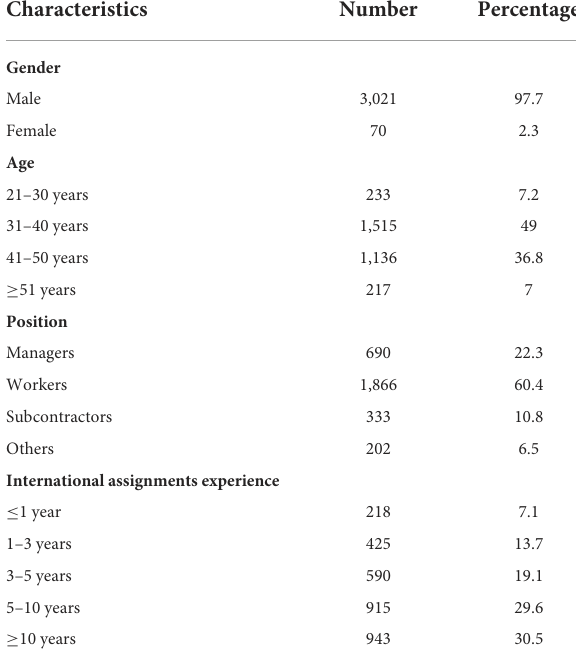
TABLE 1 Demographic characteristics of expatriates ( N =